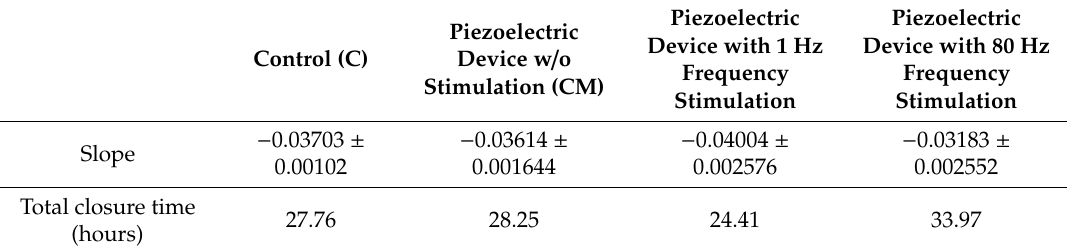
Table 1. Summary of the obtained scratch assay parameters.